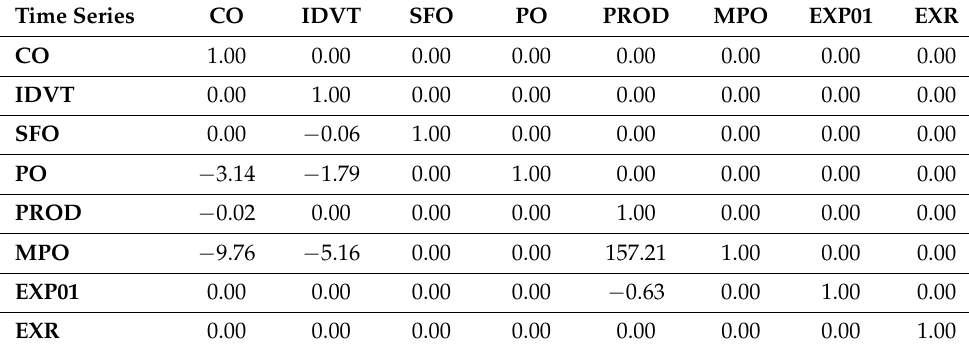
Table 12. Structural matrix A after replacing SBO with SFO.